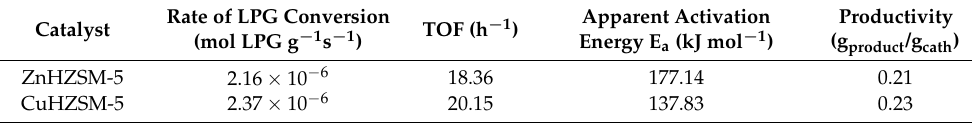
Table 3. The TOF (turn over frequency) and productivity for different catalyst in conventional reaction and reaction assisted by electric power: 100 mg catalyst, 6 mA, 10 mm gap distance and 4 wt. % metal loading.